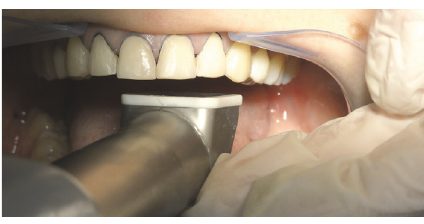
Figure 11: Milled e.max CAD